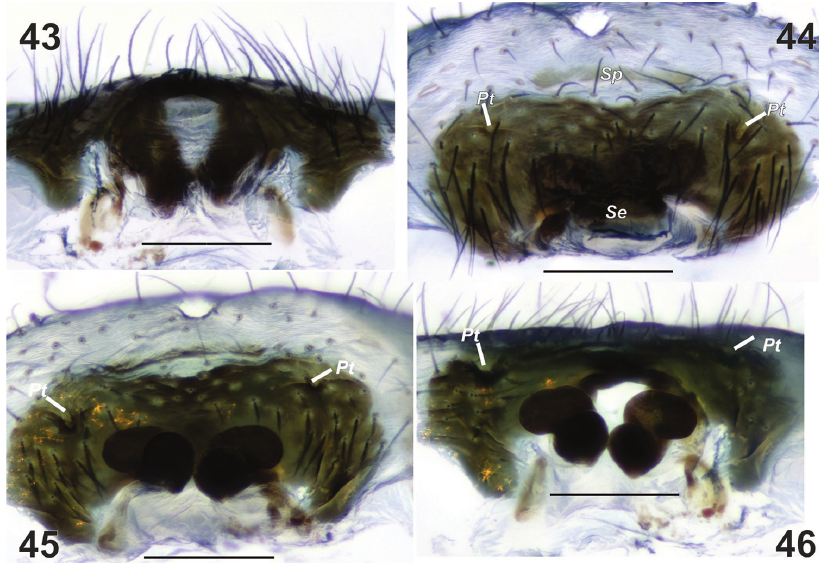
Figures 43–46. Macerated epigyne of Metellina kirgisica . 43 caudal 44 ventral 45 anterior 46 dorsal. Pt lateral pits Se sclerotised outgrowth Sp sclerotized plate. Scale bars 0.2